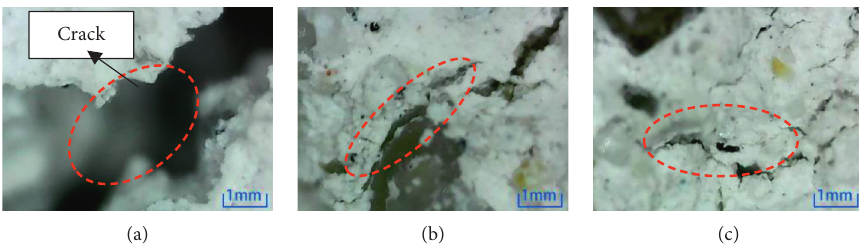
Figure 28: Microscopic observation of specimen soaked in H